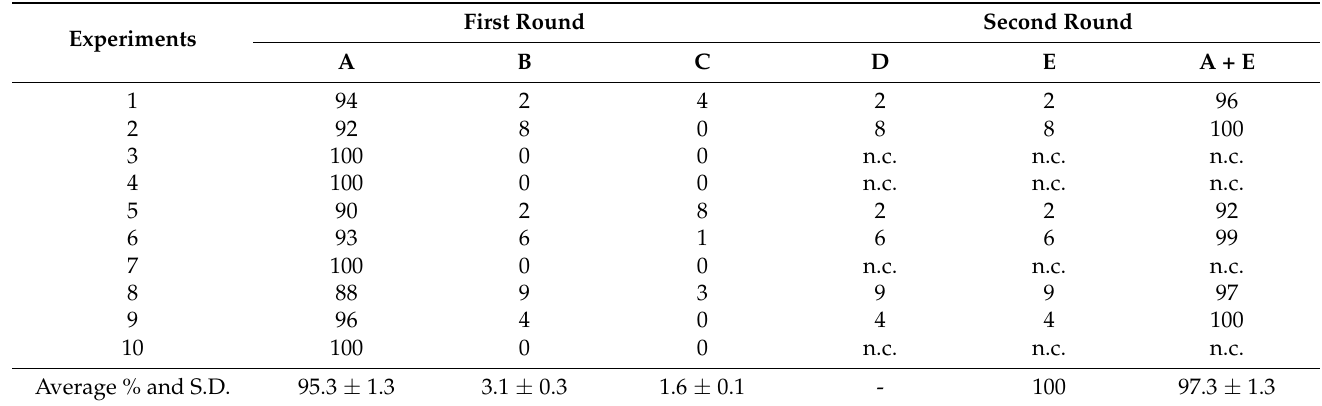
Table 1. Numbers of whiteflies captured by yellow-colored double-charged dipolar electric field screens on motor dollies during the first and second rounds of automated insect-trapping from a row of five tomato